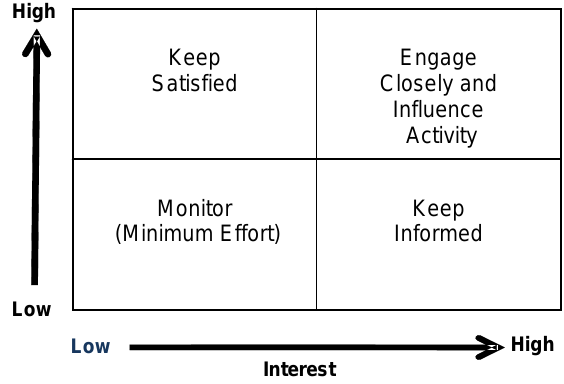
Figure 2: Power and interest grid (Freeman,